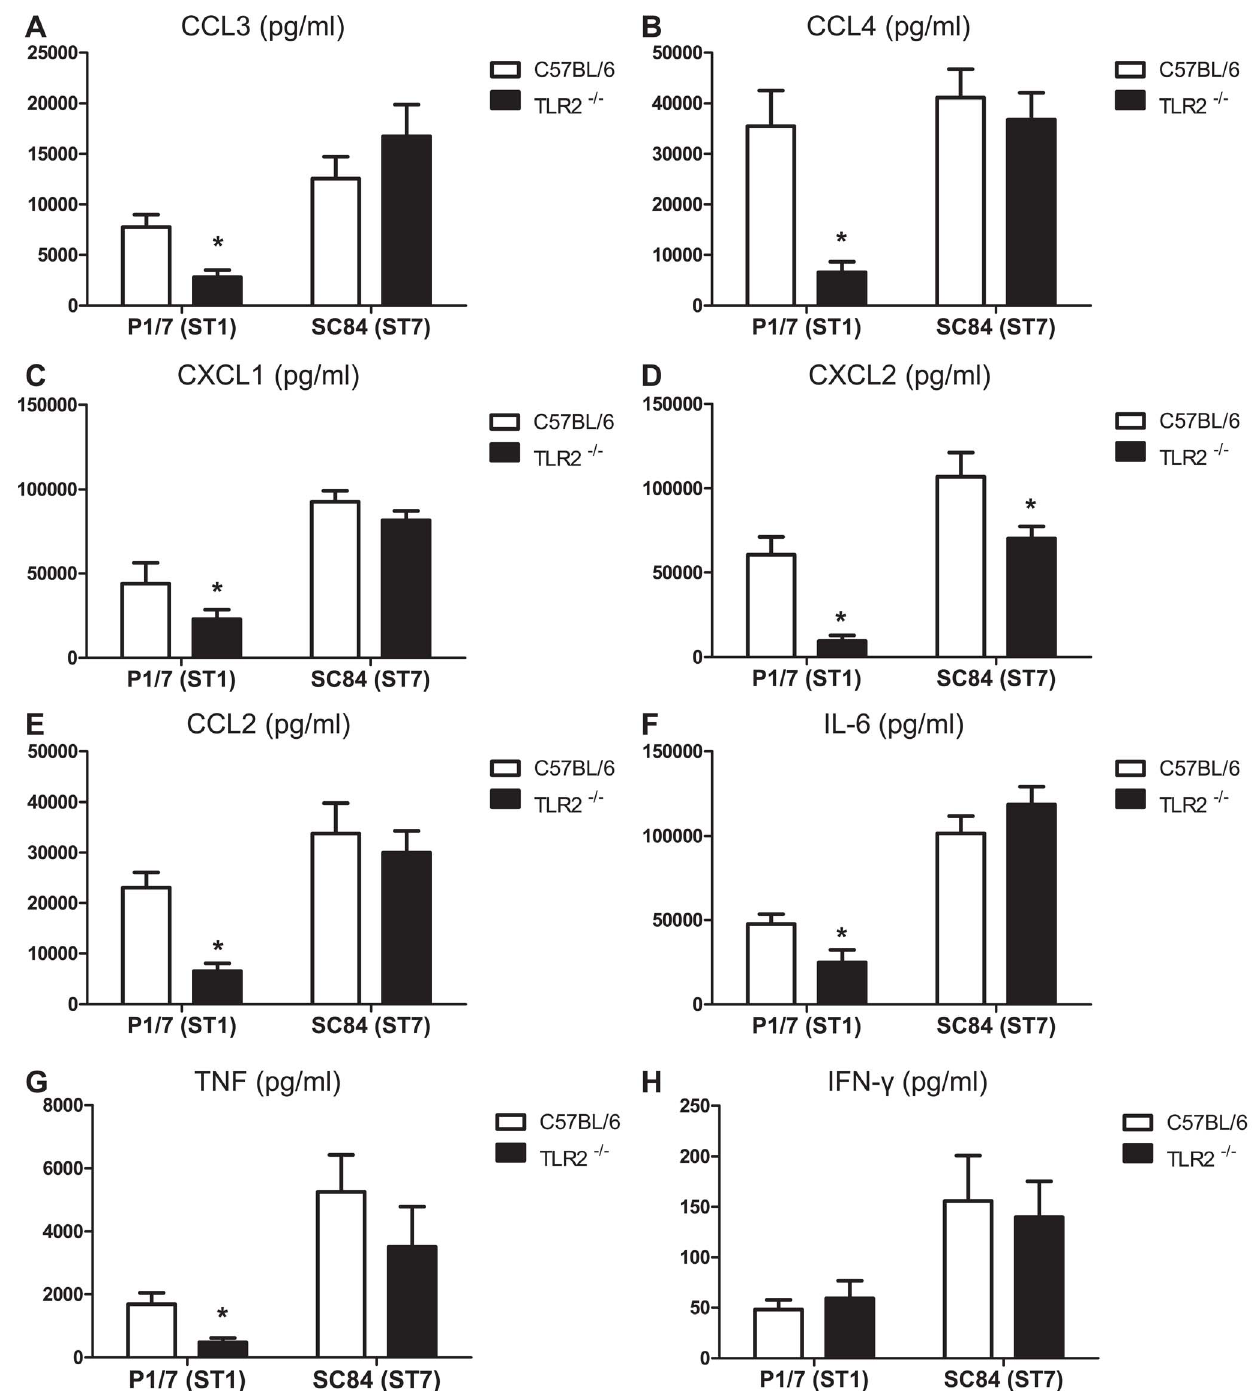
Figure 4. Production of proinflammatory cytokines and chemokines in TLR2 2 / 2 or wild-type mice infected with ST1 or ST7 strain. Production of proinflammatory cytokines and chemokines in TLR2 2 / 2 mice infected with S. suis highly virulent strain ST1 is lower than in wild type counterparts, whereas no differences are observed when animals are infected with epidemic strain ST7. Plasma levels of cytokines and chemokines in C57BL/6 and TLR2 2 / 2 mice infected with 1 6 10 7 CFU of S. suis strain P1/7 (ST1) or SC84 (ST7) for 6 h, as quantified by Luminex. Plasma samples were tested for the cytokines and chemokines indicated at the top of each panel. Data represent mean values 6 SEM in pg/ml. * P , 0.05 indicates statistically significant differences between infected TLR2 2 / 2 group and its wild-type infected counterpart as determined by t- test. doi:10.1371/journal.pone.0065031.g004 TLR activation between an European ST1 and the ST7 epidemic we hypothesize that different bacterial components, especially strain were observed also with washed heat killed suspensions, differences in lipoproteins (secreted or not) present in typical S. suis indicating a lower implication of secreted components [20]. Thus, strains and those from the epidemic S. suis ST7 strain may vary